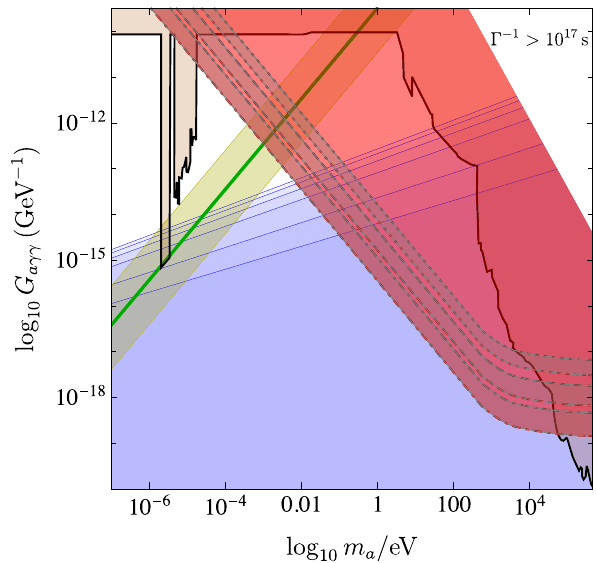
Fig. 3 Combined bounds on the decay constant G a γγ (in units of GeV − 1 ) as a function of ALP mass m a (in units of eV ) . Note that the corresponding photon energy is half the ALP mass. The grey-shaded area (surrounded the black solid curve) indicates bounds for the stan- dard scenario without halos, the light-green-shaded band shows var- ious axion models around the QCD-axion scenario (green line), and the blue-shaded regions indicate different thermal-mass models using the realignment mechanism (see Ref. [37] for details). The red-shaded regions represent our results for three different choices of halo masses M in the combined dark-matter scenario, which are M = 10 − 5 M (cid:4) (upper band), M = 0 . 1 M (cid:4) (middle band), and M = 10 3 M (cid:4) (lower band), respectively. In each band, the lower (more restrictive) bound- ary utilizes a halo dark-matter fraction of one, whereas the upper (less restrictive) boundary utilizes the maximally allowed dark-matter frac- tion from various observations (see main text for details). The white area in the upper-right corner depicts the region of parameter space in which the ALP halos have already decayed G a γγ (cid:2) 10 − 17 . 0 GeV − 1 for M ≥ 10 − 5 M (cid:4)